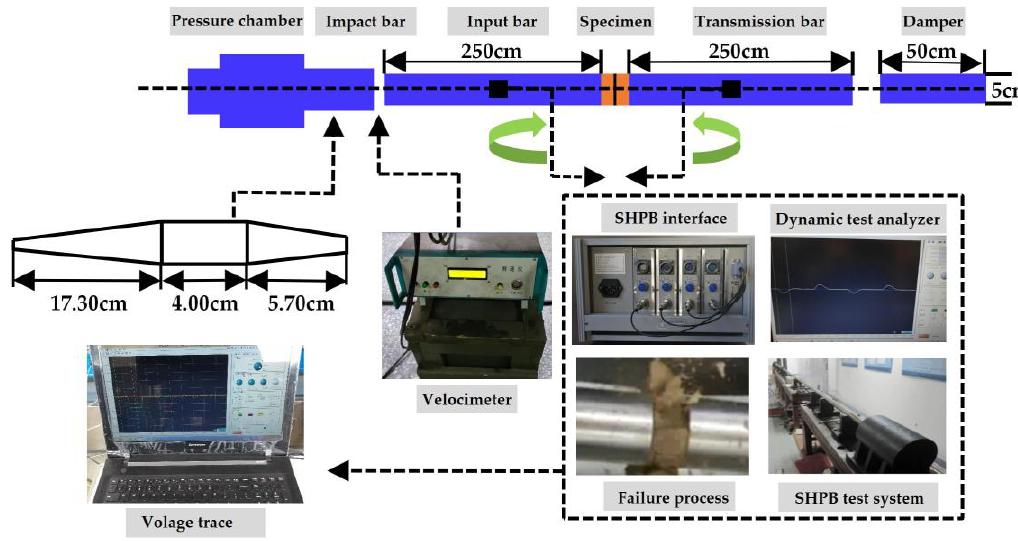
Figure 5. Structure of the SHPB test